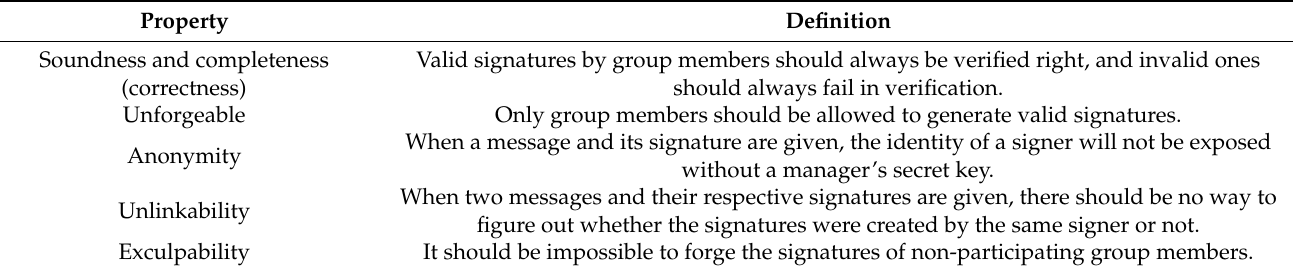
Table 1. Group Signature property and